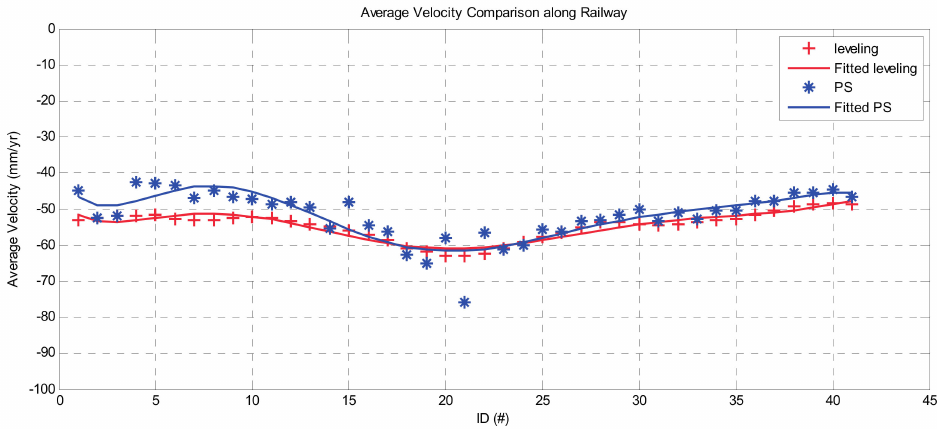
Figure 6. The average subsidence velocity comparison along the railway